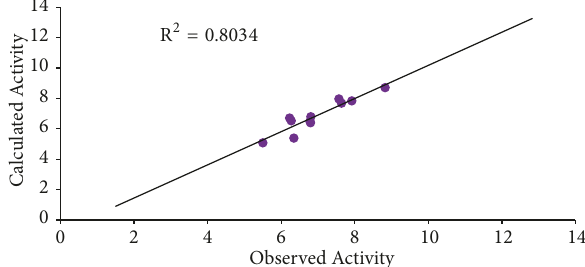
Figure 2: Plot of calculated activity against observed activity of test set.